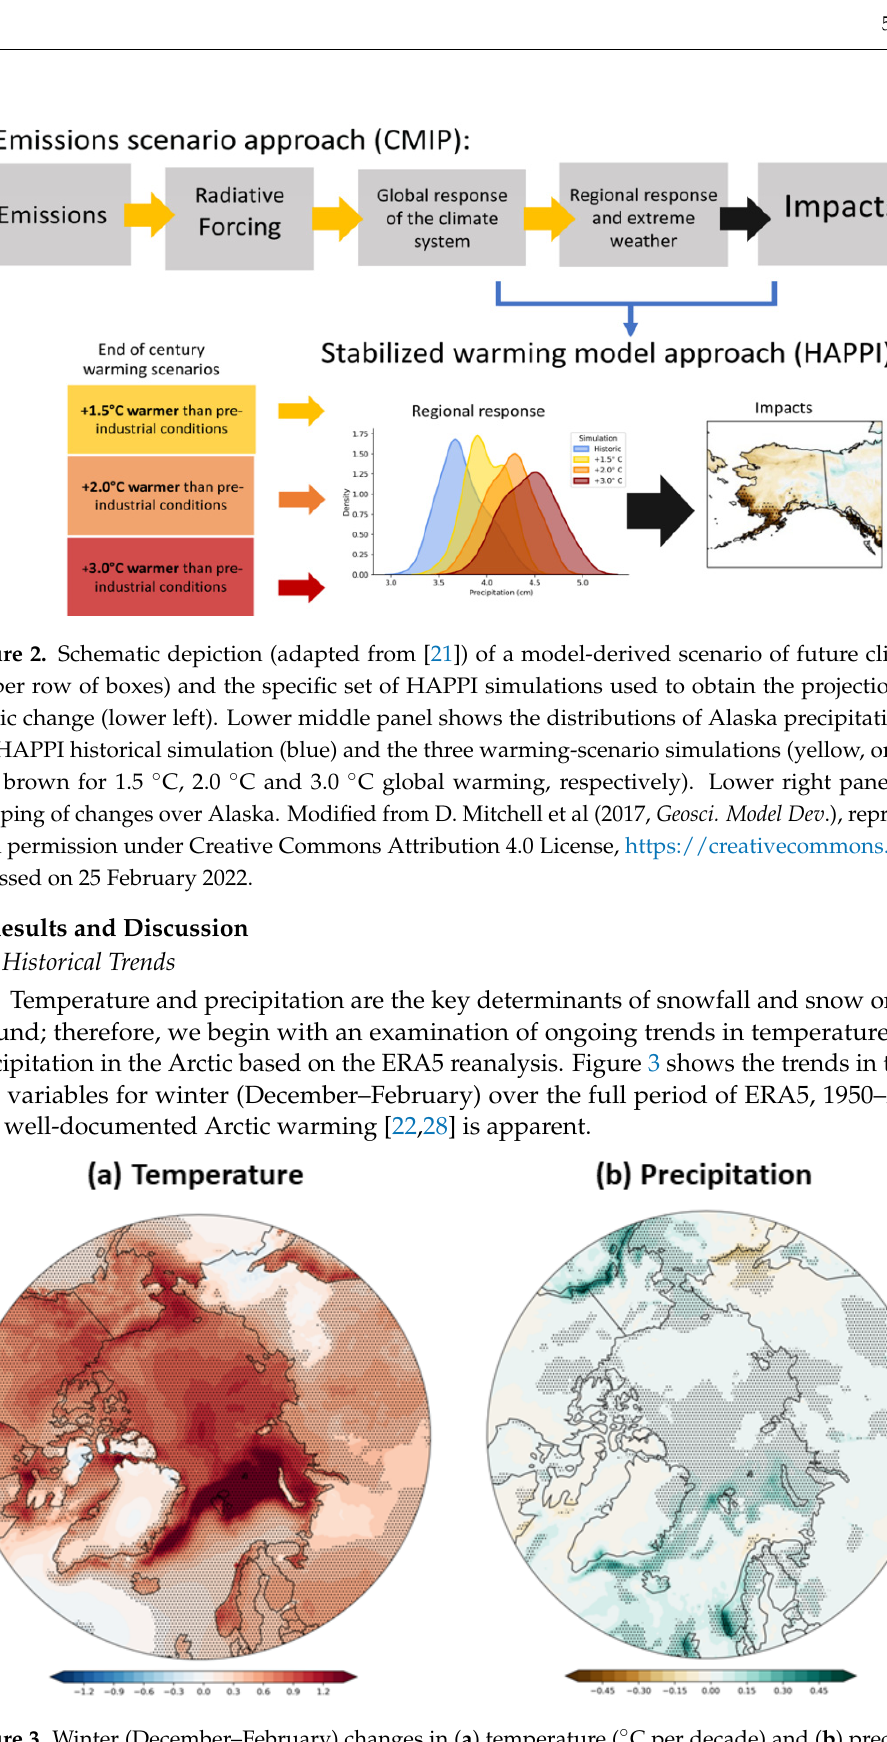
Figure 3. Winter (December–February) changes in ( a ) temperature (°C per decade) and ( b ) precipitation (mm per decade) over the period 1950–2020. In stippled areas, changes are statistically significant at the 0.05 level. Data source: ERA5 reanalysis.